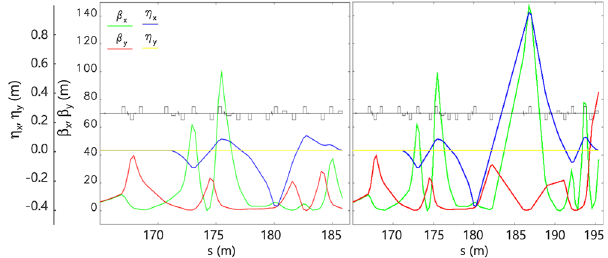
FIG. 2. Betatron and dispersion functions from the FERMI linac end to the switchyard end, for the FEL2 (left) and FEL1 beam lines. The septum is placed in proximity of the maximum negative dispersion peak ( s ¼ 180 m). Quadrupole magnets are in gray.